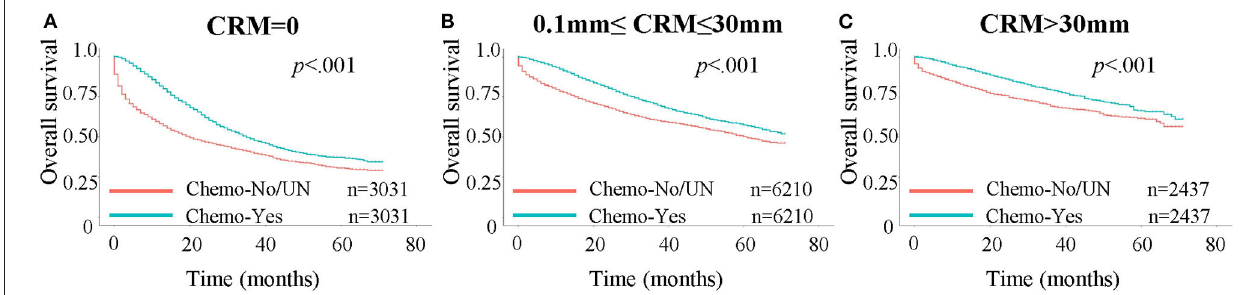
FIGURE 3 | Kaplan-Meier curves for OS in patients stratified by chemotherapy status. A 1:1 propensity score matching was performed, with stratification for age, AJCC stages, number of regional lymph nodes examined and positive regional lymph nodes. Chemo: chemotherapy; UN: unknown. (A) OS in patients with CRM values = 0mm. (B) OS in patients with CRM values between 0 and 30mm. (C) OS in patients with CRM values larger than 30mm.